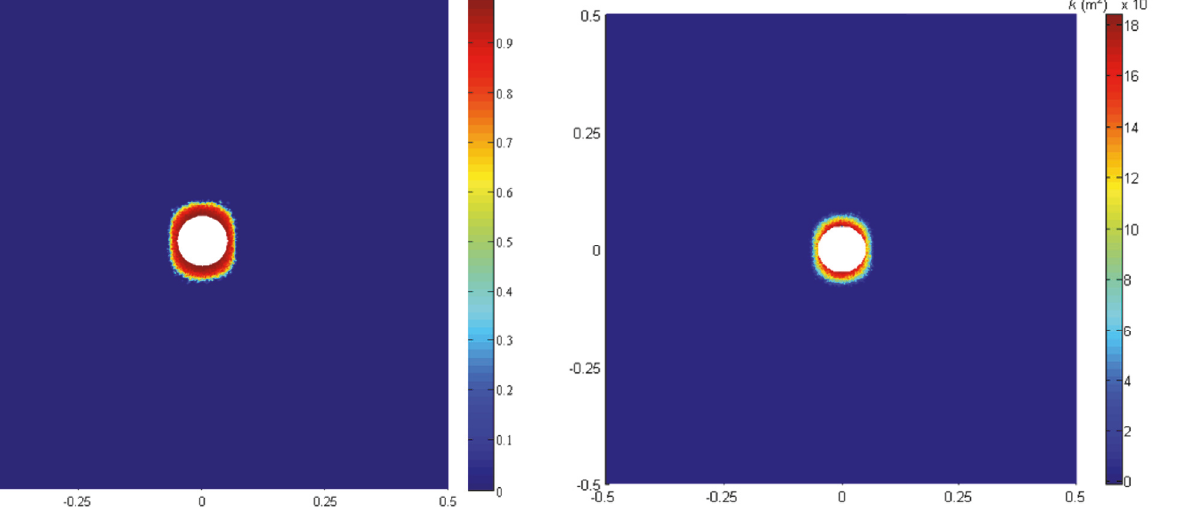
Figure 12: Permeability distribution of surrounding rock under lateral pressure coefficient 𝜆 𝜎 = 1.5